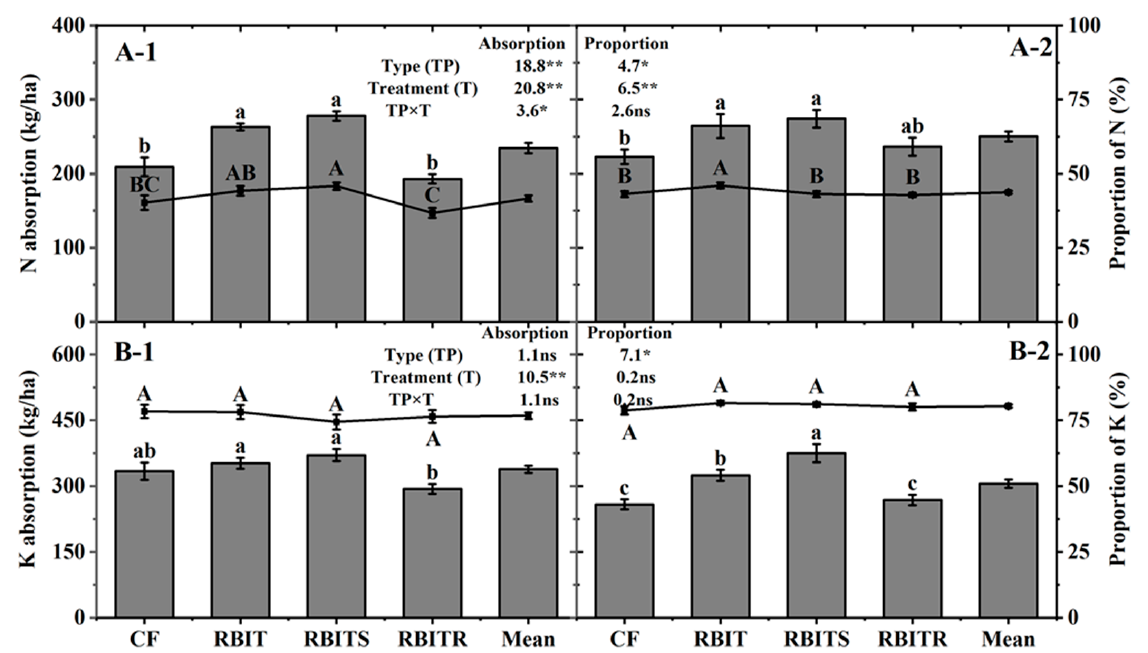
Figure 3. Effect of fertilization management on the nutrition absorption and the proportion of N and K in the stem + leaf under High-DTL ( A-1 , B-1 ) and Low-DTL ( A-2 , B-2 ). Note: High-DTL: High daytime temperature and light after heading; Low-DTL: Low daytime temperature and light after heading; CF: conventional fertilization; RBIT: reduced basal and increased topdressing fertilizer rate; RBITS: RBIT combined with straw incorporation; RBITR: RBIT combined with reduced fertilizer rate. The different lowercase letters indicate the difference in nutrient absorption among treatments at the p < 0.05 level under High-DTL and Low-DTL, respectively. The different uppercase letters show the difference in nutrient proportion among treatments at the p < 0.05 level under High-DTL and Low-DTL, respectively. *: p < 0.05; **: p < 0.01; ns: non-significance. Table 4. Effect of fertilization management on the nutrient concentrations and N/K in different rice parts under High-DTL and Low-DTL.